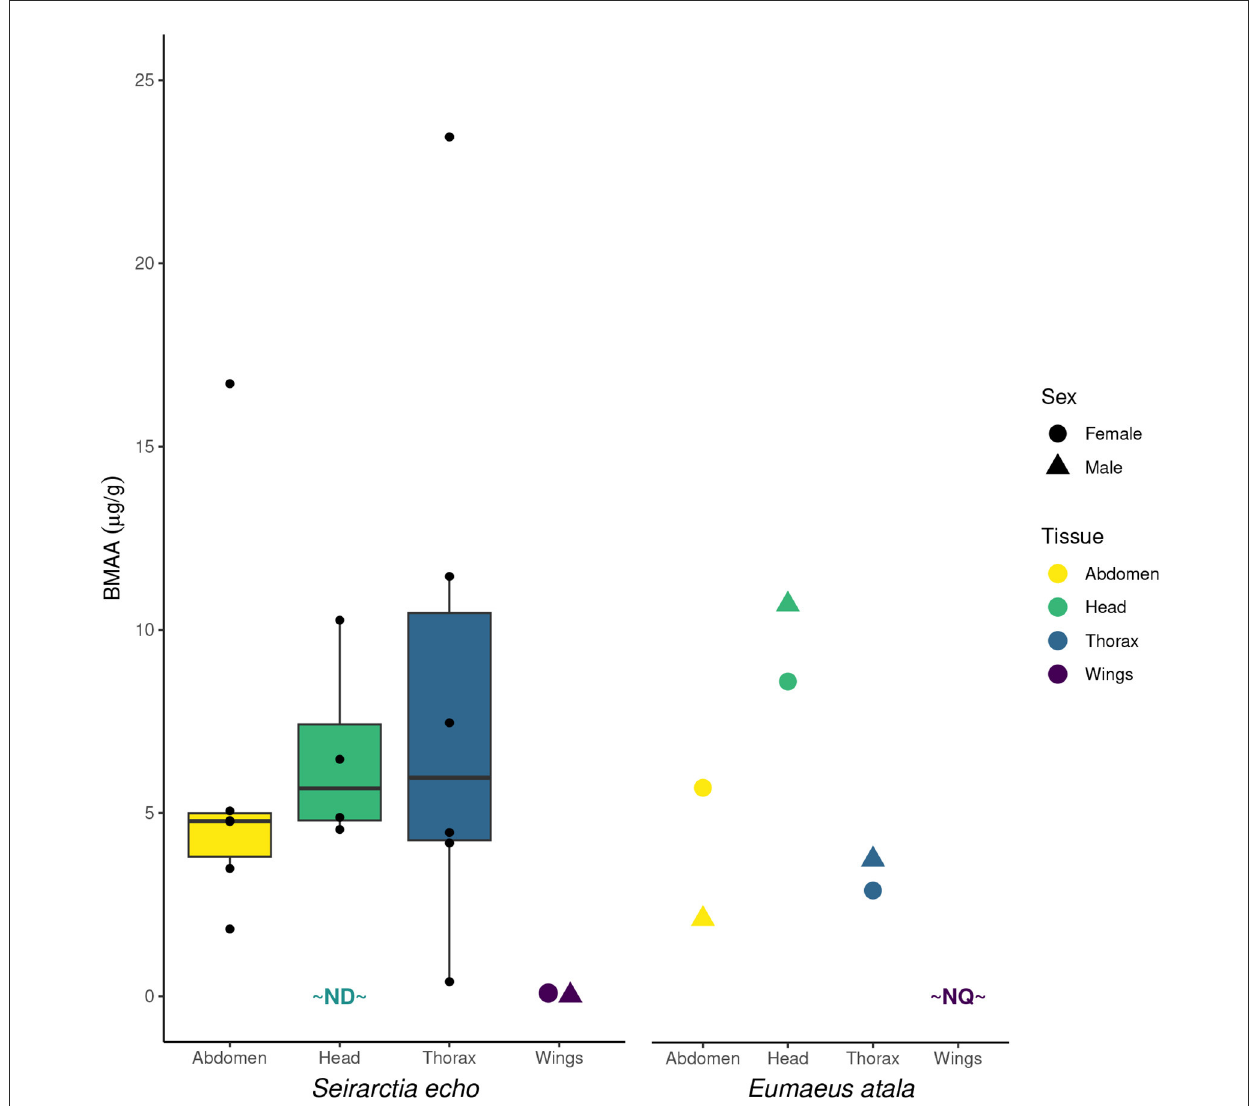
FIGURE4 Total BMAA quantified in the tissues of cycad-reared male and female Seirarctia echo (left) and Eumaeus atala (right) adults. Colored data points represent 6 pooled individuals, whereas boxplots include 6 males and 6 females (unpooled). Even after pooling, wing mass was too low to be measured so plotted values represent per-individual BMAA quantities. ND, not detected; NQ, below the lower limit of